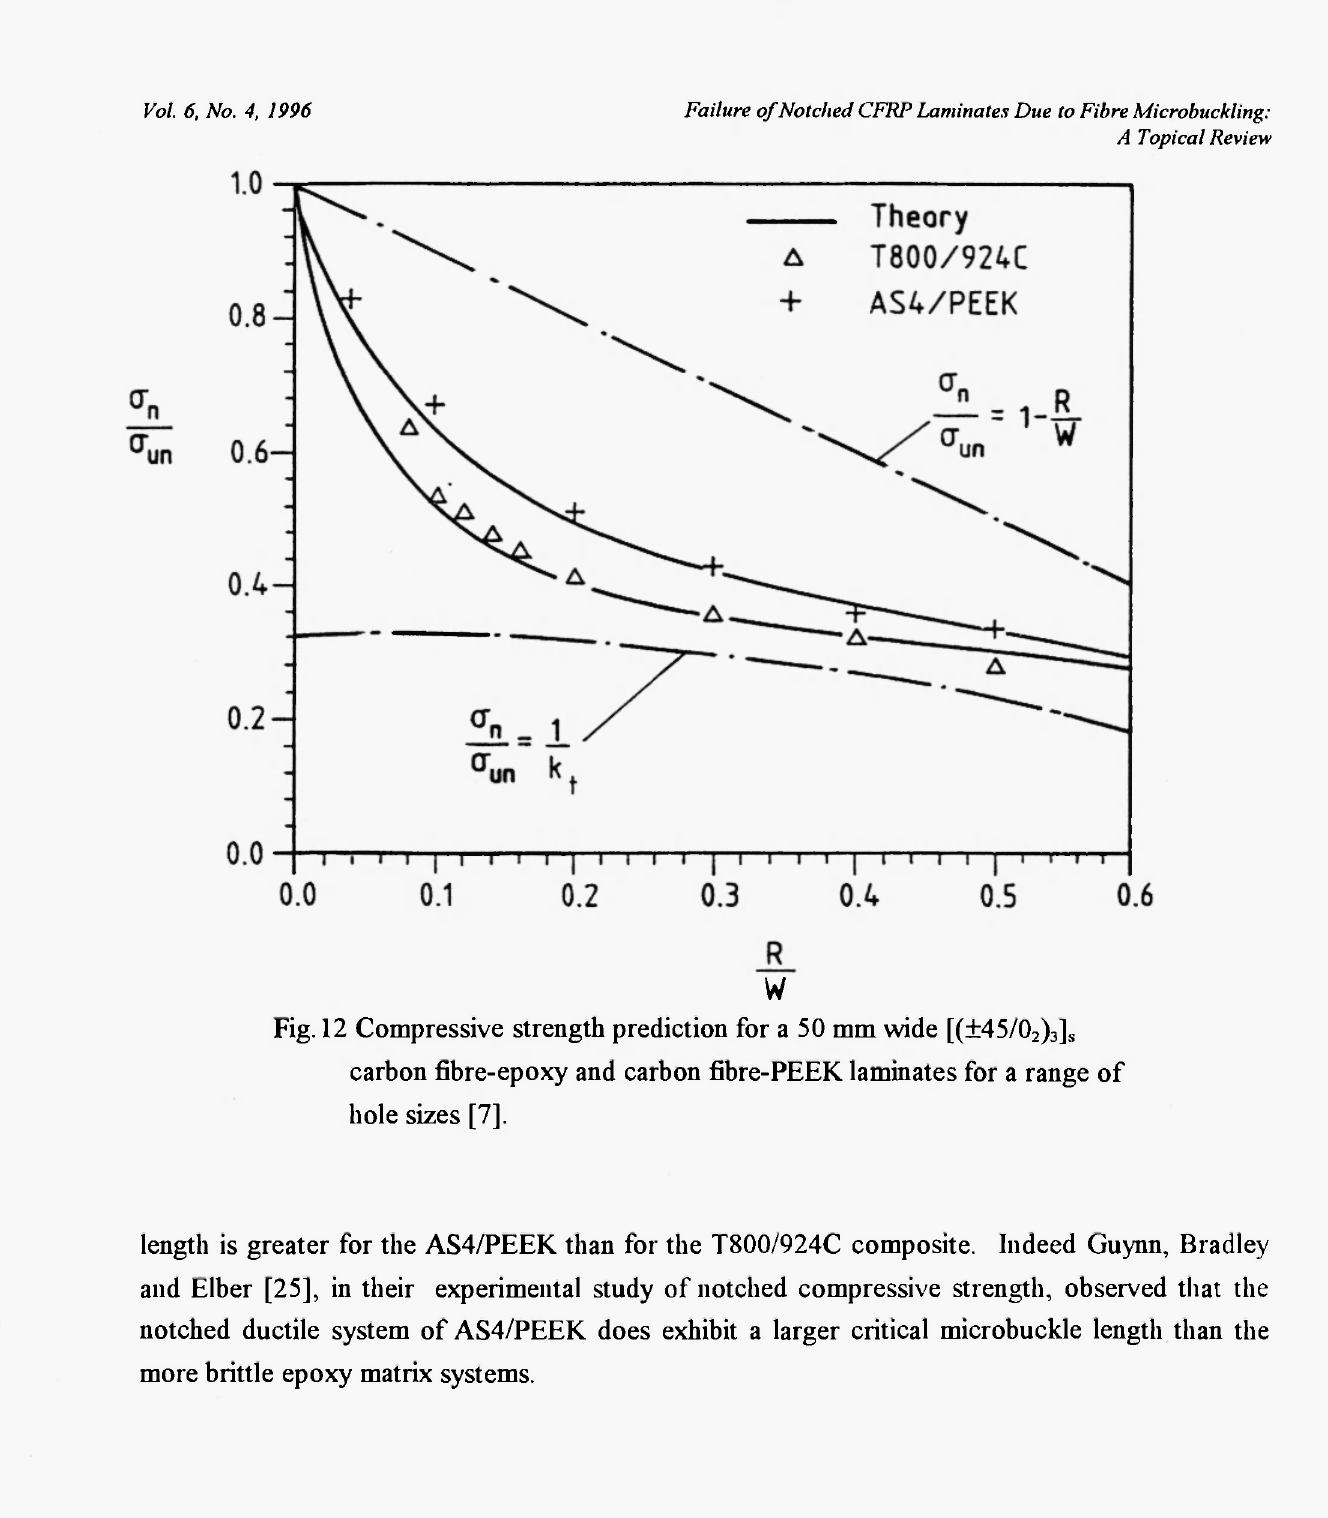
Fig. 12 Compressive strength prediction for a 50 mm wide [(±45/0 carbon fibre-epoxy and carbon fibre-PEEK laminates for a range of hole sizes